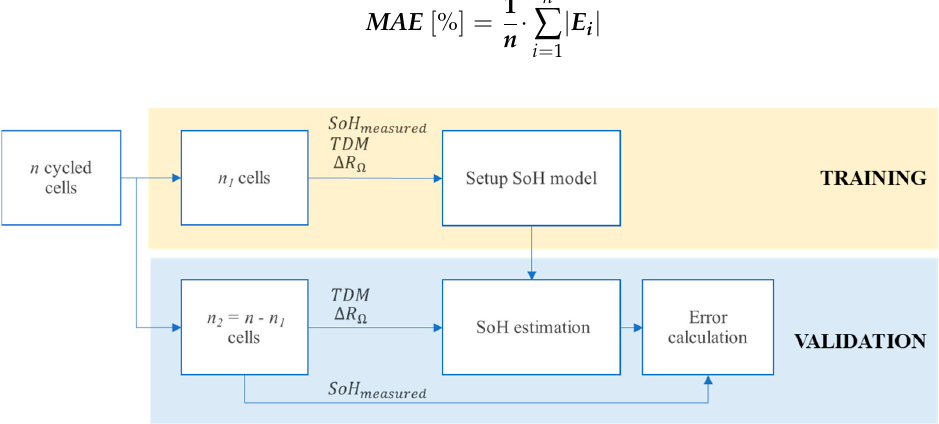
Figure 6. Algorithm to evaluate the developed SoH model with training and validation